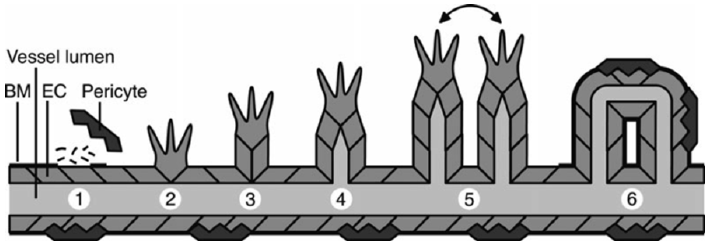
Figure 5. Angiogenesis. Illustration of the angiogenesis cascade that involves: (1) pericyte detachment and basal membrane degradation in response to endothelial cell activation; (2) migration of endothelial tip cells in the direction of the growth factor gradient; (3) provision of support of endothelial tip cells by the underlying stalk cells; (4) continuation of this process to form luminized vessel sprouts; (5) fusion of sprouts; and (6) formation of a functional vessel which is further stabilized by deposition of a basal membrane and attraction of pericytes for structural support [3]. Figure reproduced with permission from Reference [3]. BM, basal membrane; EC, endothelial cell.